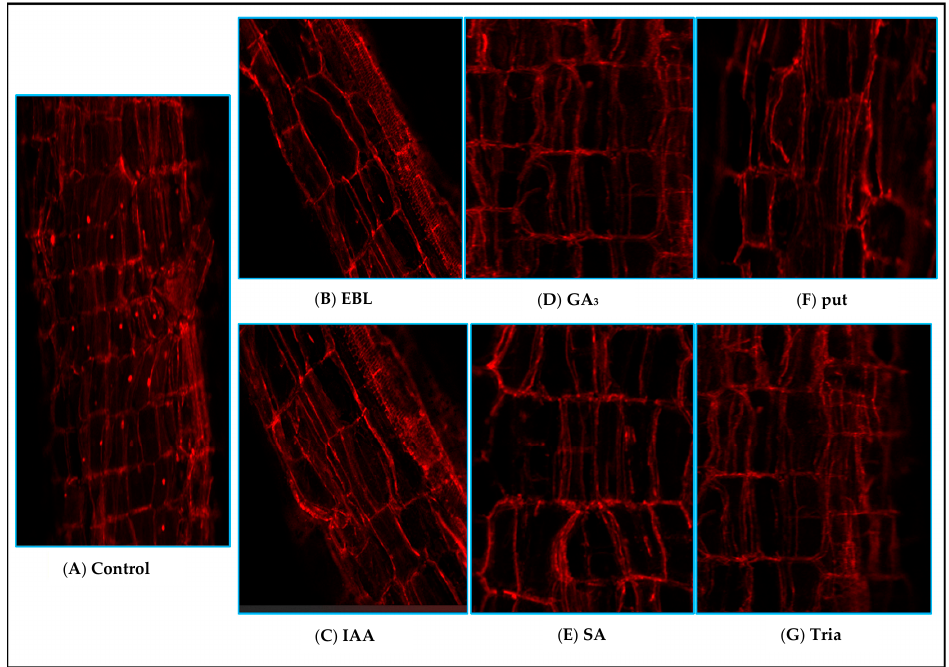
Figure 7. Confocal microscopic images, assessing the viability of root cells of the Nath Sona mustard cultivar at 90 DAS. Results for the ( A ) Control and ( B – G ) plants treated with EBL, IAA, GA 3 , SA, put and Tria.